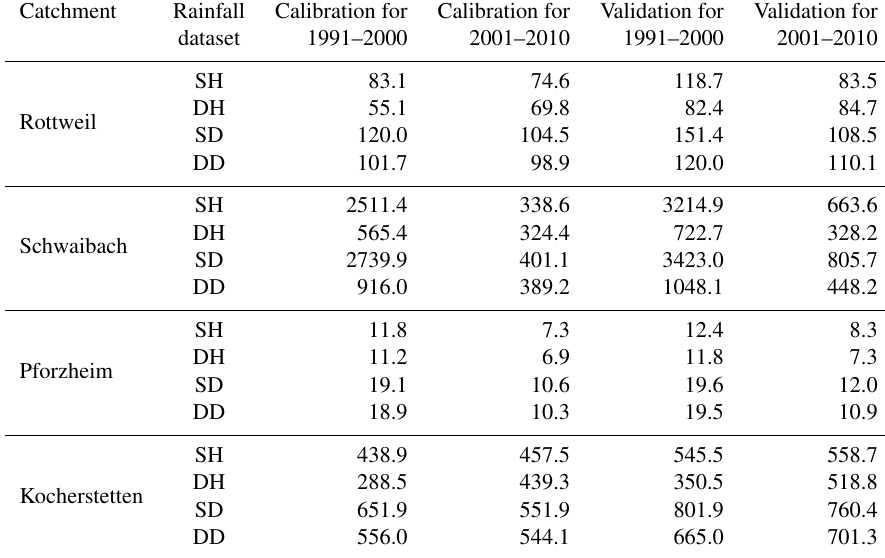
Table 6. Mean square error for flows higher than the 10th percentile of flow for the distributed HBV model. Catchment Rainfall Calibration for Calibration for Validation for Validation for